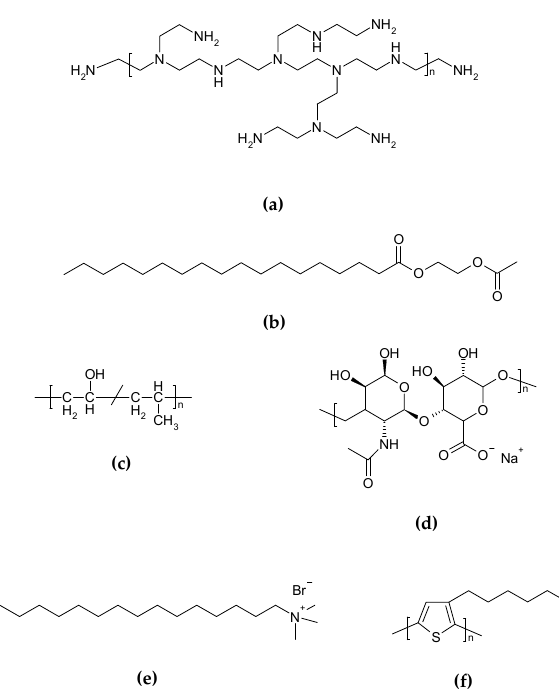
Figure 7. Chemical structure of common stabilizing agents used to prepare colloidal dispersions of GLN: ( a ) PEI; ( b ) AGS; ( c ) PVA; ( d ) SH; ( e ) CTAB; ( f ) P3HT.